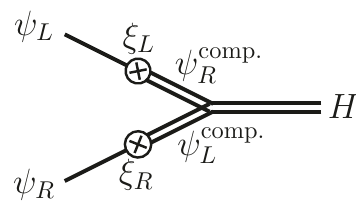
Figure 9 . Origin of the Yukawa couplings to SM fermions in the dual